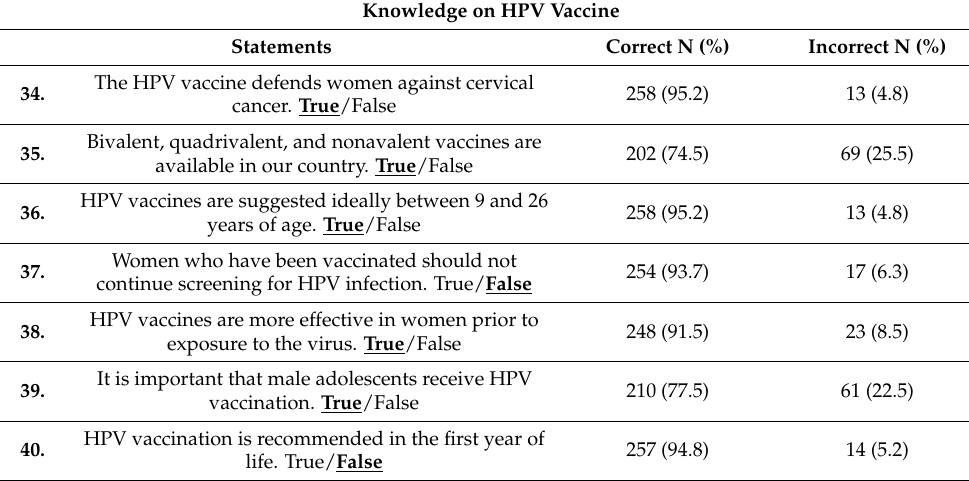
Table A3. Survey responses assessing pediatric dentists’ knowledge on HPV vaccine. Statements